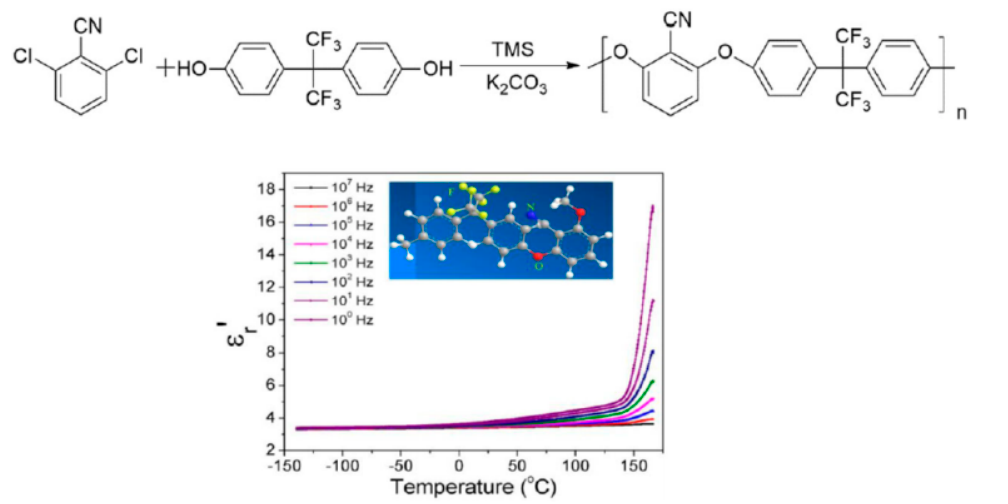
Figure 3. Components of the dielectric constant ( ε ’ r ) as a function of temperature at different frequencies for fluorinated and cyanated poly(arylene ether nitrile). Adapted from reference [9] with permission. Copyright 2018, Wiley.